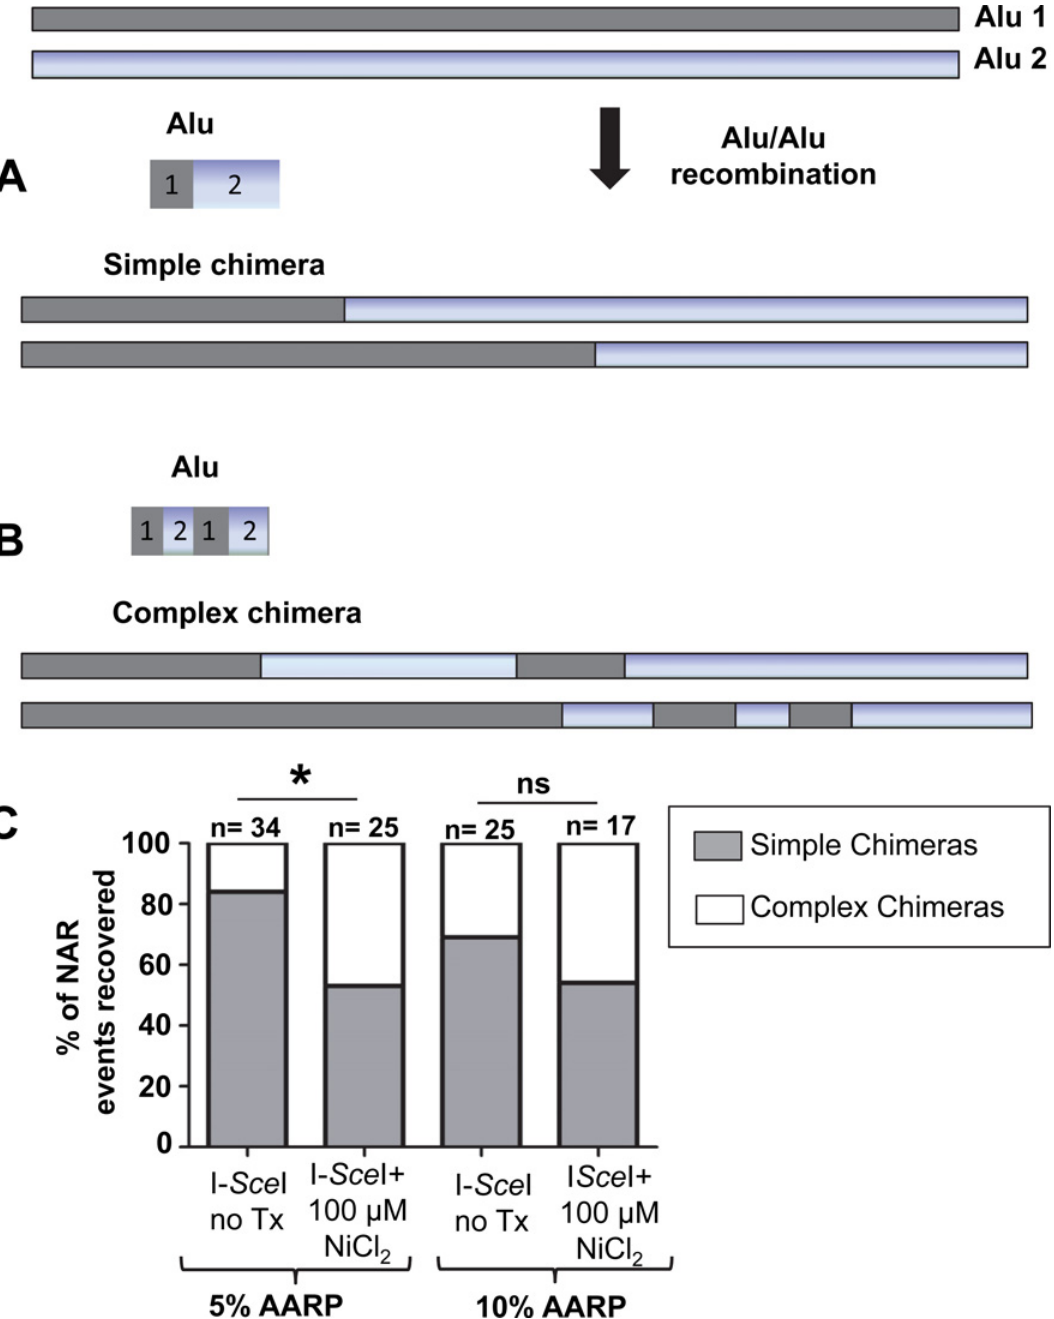
Fig 4. Distribution of single and complex chimeras. Alu-Alu recombination can generate two types of outcomes: simple chimera or complex chimera. A. A simple chimera shows only one recombination site (left portion of the Alu sequence chimera derived from Alu1 and right portion derived from Alu2). B. A complex chimera shows multiple recombination sites with intermixed regions of the chimera derived from the two Alu sequences. Schematic of actual recovered outcomes are shown below the diagrams. C. The 5 and 15%AARP HEK 293 cell line was incubated with media containing 100 μ M NiCl 2 . Untreated cells were used as the reference control. Sequence analyses of the recovered events showed that two types of Alu-Alu recombination products can be observed: simple and complex. NAR events recovered from the nickel treated cells were further classified as single (gray) or complex chimeras (white). The results are expressed as mean ± SD of three independent experiments. Statistical differences are indicated as * P < 0.05; (Fisher ’ s exact test); ns = not significant. Numbers above each column represent the total colonies analyzed; sequence alignments are shown in S7